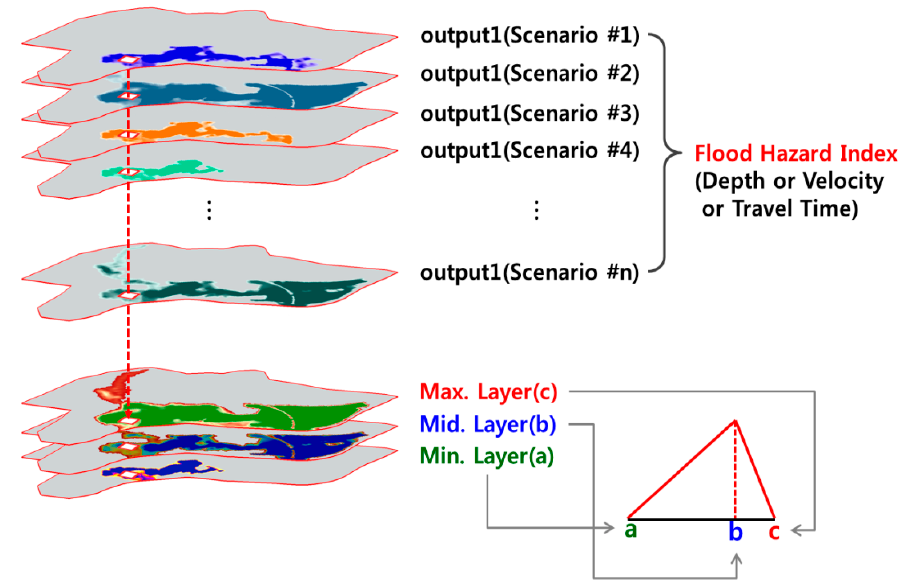
Figure 4. Composition of triangular fuzzy membership function.